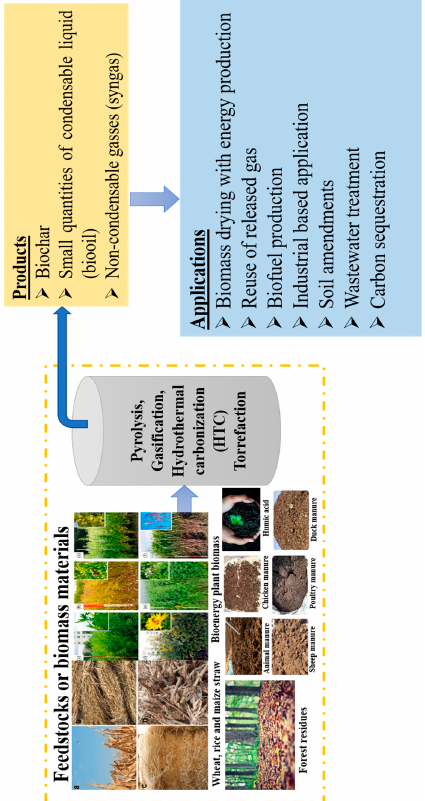
Figure 2. Feedstocks utilization and their applications.